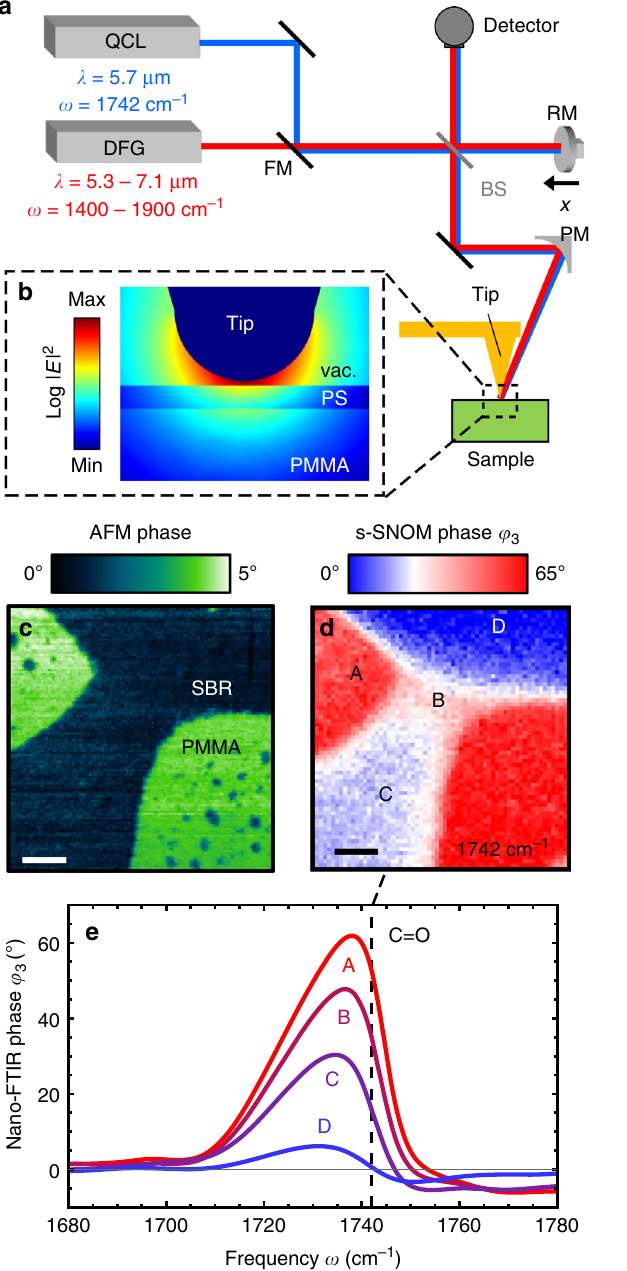
Fig. 1 Near- fi eld imaging and spectroscopy of organic nanocomposites. a Illustration of the s-SNOM and nano-FTIR setup. A quantum cascade laser (QCL) is used for s-SNOM imaging. An infrared laser continuum based on difference frequency generation (DFG) is used for nano-FTIR spectroscopy. The light source is selected with a fl ip mirror (FM). A parabolic mirror (PM) is used for focussing the laser radiation onto the tip apex. After collection of the tip-scattered light with the PM, a Michelson interferometer comprising a beam splitter (BS) and moveable reference mirror (RM) is used for detection. b Simulated near- fi eld distribution around a tip apex (30 nm radius) above a 10 nm-thick PS layer on PMMA. For simulation details see “ Methods ” section. c AFM mechanical phase image of a two-component rubber blend (SBR/PMMA) and d corresponding s-SNOM phase φ 3 image recorded at 1742 cm − 1 , which maps the absorption of the C = O vibrational mode of PMMA. Scale bar: 200 nm. e Nano-FTIR phase φ 3 spectra of selected positions A – D. Vertical dashed line marks the imaging